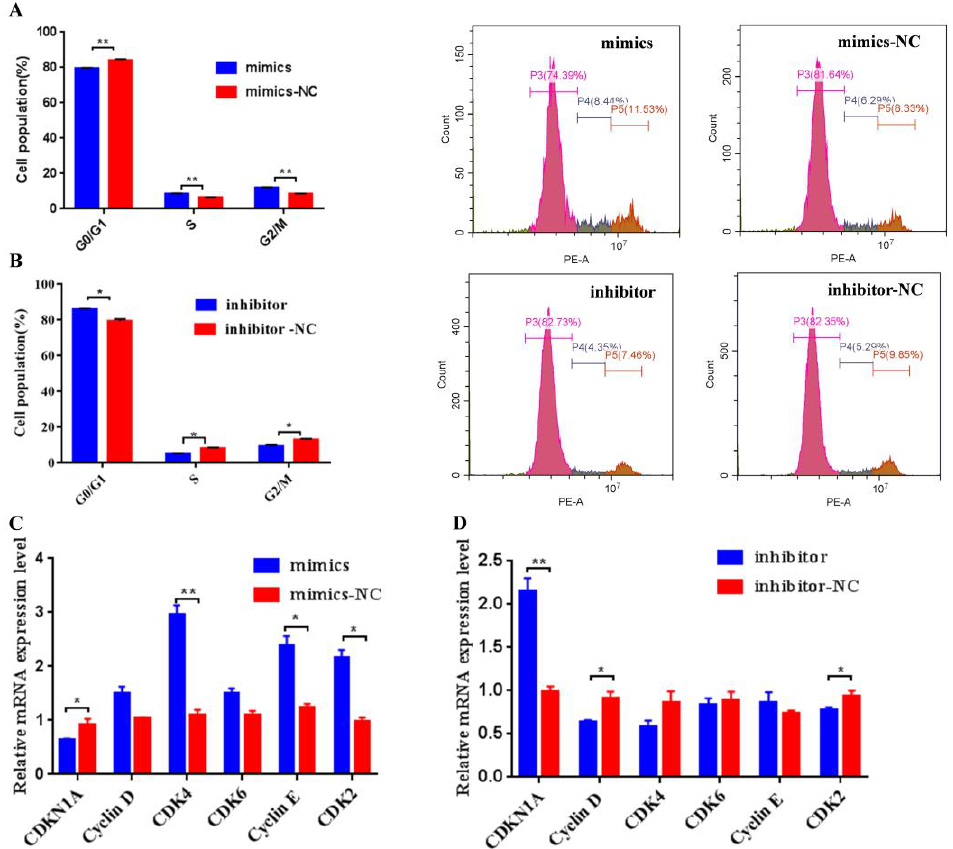
Figure 4. Bta-miR-106b promoted cell cycle progression from G0/G1 to the S phase in BMECs. ( A ) and ( B ) Distribution of cell cycle phases of BMECs with propidium iodide (PI) staining after transfection with bta-miR-106b mimics and bta-miR-106b inhibitors for 48 h. ( C ) and ( D ) The mRNA expression of cell cycle regulators specific to the G1/S phase in BMECs with bta-miR-106b mimics and inhibitors with qRT-PCR. (Note: * means p value < 0.05; ** means p value < 0.01.)